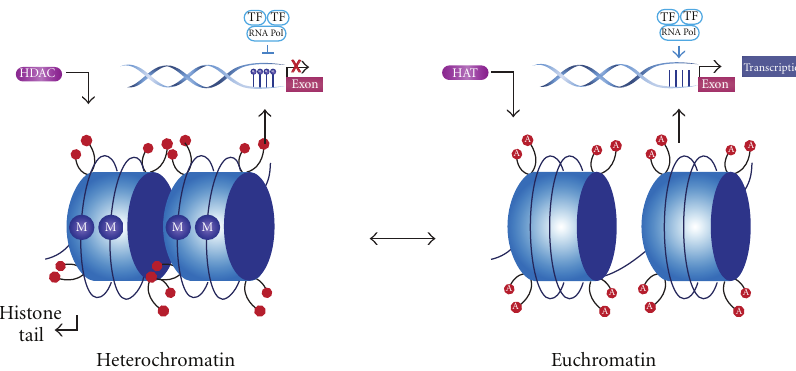
Figure 4: Histone modification. To form heterochromatin, histone deacetylation of histone tails caused by HDACs enzymes in association with DNA methylation (M) confers a dense configuration of DNA that prevents its transcription. In the euchromatin state, there is an acetylation of histone tails (A) by HATs enzymes in association with DNA demethylation to promote gene